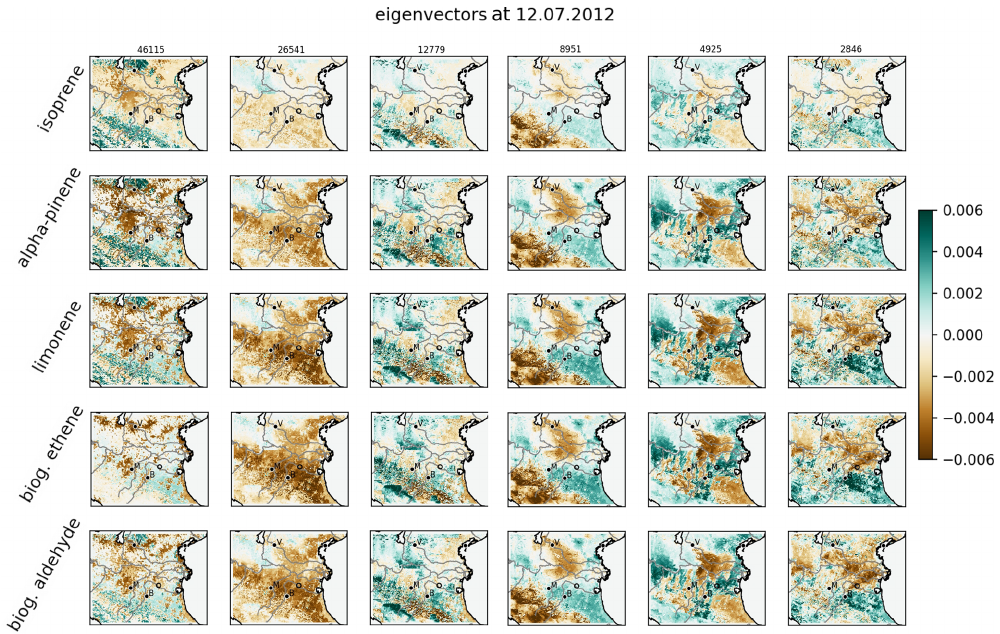
Figure 6. Leading eigenvectors for combined sensitivities. The normalized eigenvectors are visualized as column of fields of different biogenic gases. Numbers above each column show the eigenvalues of the corresponding eigenvector.